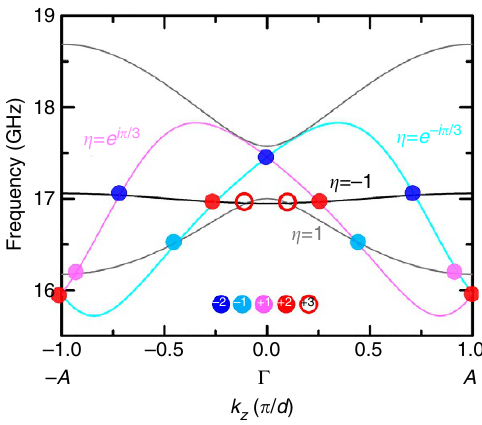
Figure 4 | Triple Weyl points along the C – A direction. Two red open circles highlight the triple Weyl points with a topological charge of þ 3. Other crossing points (solid circles) between different representations also exist on this C 6 axis. These crossing points carry topological charges of ± 1 or ± 2, which are indicated by the colours of the circles. Note that the single Weyl points at B 16.5GHz, marked by light blue circles, are type-II Weyl points as well.